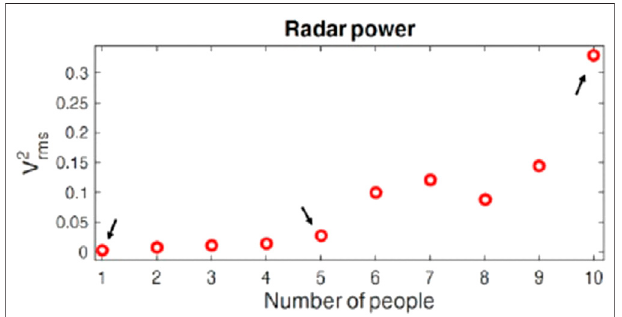
FIGURE 9 | Experimental results with ten occupants in an indoor environment. The RSS of the received signal is signi fi cantly different for different numbers of occupants. From Yavari et al. (2018).